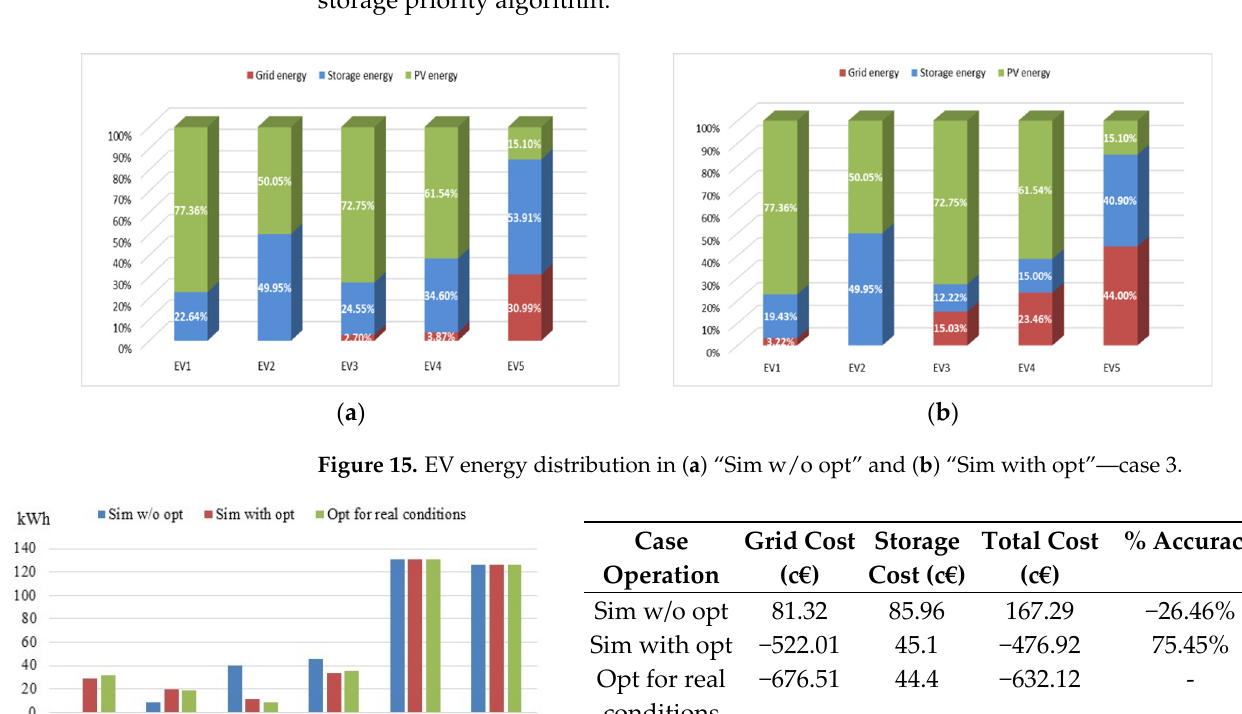
Figure 15. EV energy distribution in ( a ) “Sim w/o opt” and ( b ) “Sim with opt”—case 3.